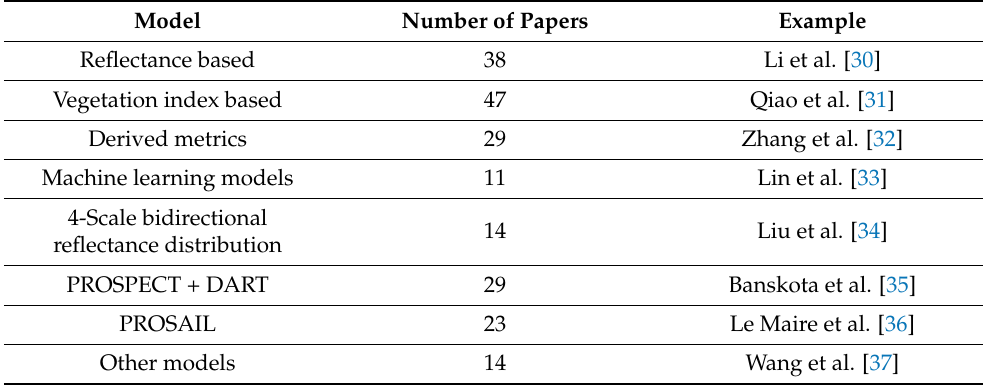
Table 3. Most used model